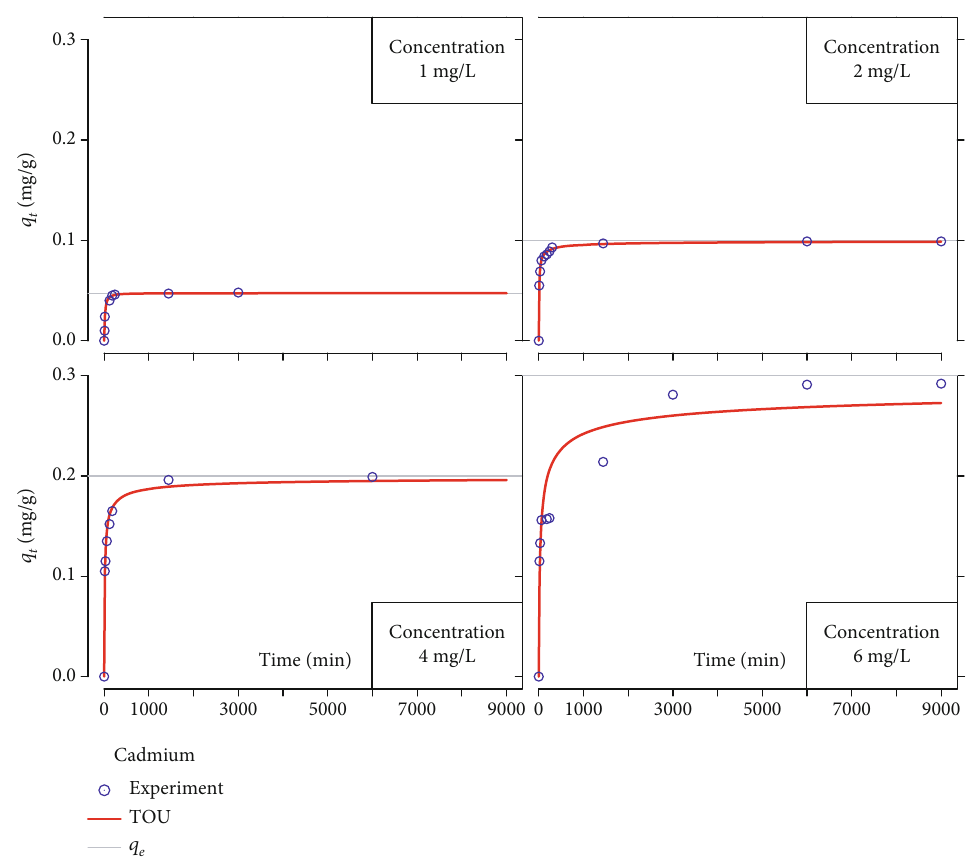
Figure 9: Adsorption kinetics for the removal of cadmium by reed leaves for four initial Cd(II) concentrations and the theoretical curve obtained from the TOU Table 5: Estimated values of the parameters of the TOU model and goodness-of- fi t measures for the adsorption of Cd(II) by reed leaves for initial Cd(II) concentrations of 1, 2, 4, and 6 mg/L.